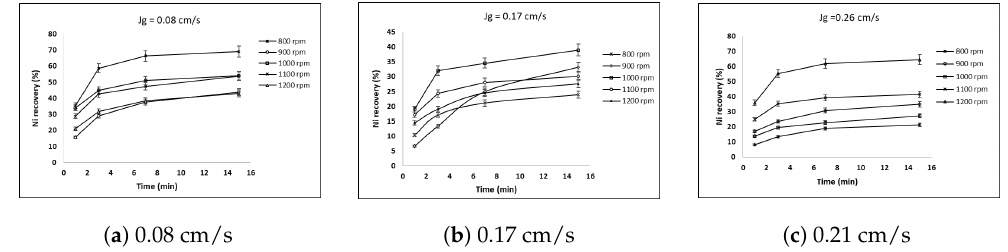
Figure 13. Recovery of nickel vs. time with different J g values ( a ) 0.08 cm/s, ( b ) 0.17 cm/s and ( c ) 0.26 cm/s) using a 6 cm impeller diameter.